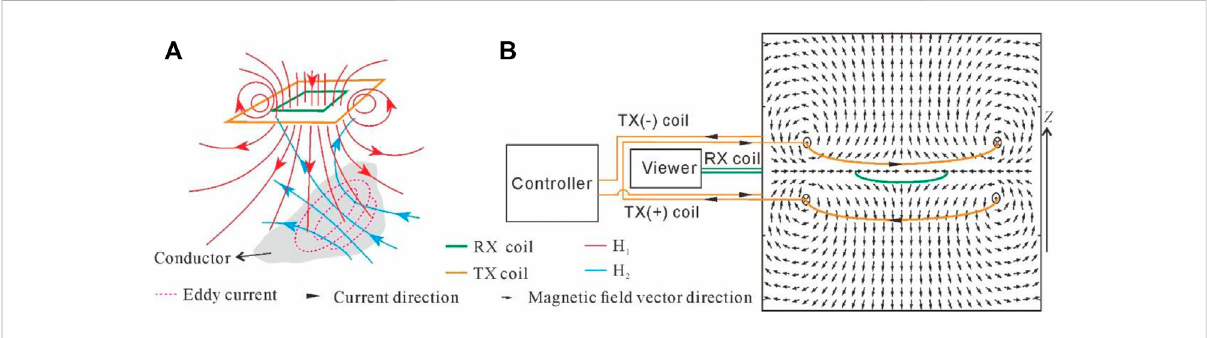
FIGURE 1 Schematic diagram of the TEM working principle. (A) Central loop device and the electromagnetic induction process of TEM coils. (B) OCTEM device diagram and magnetic fi eld distribution in space after the reverse power supply. The receiving coil indicated by green is located at the zero- fl ux